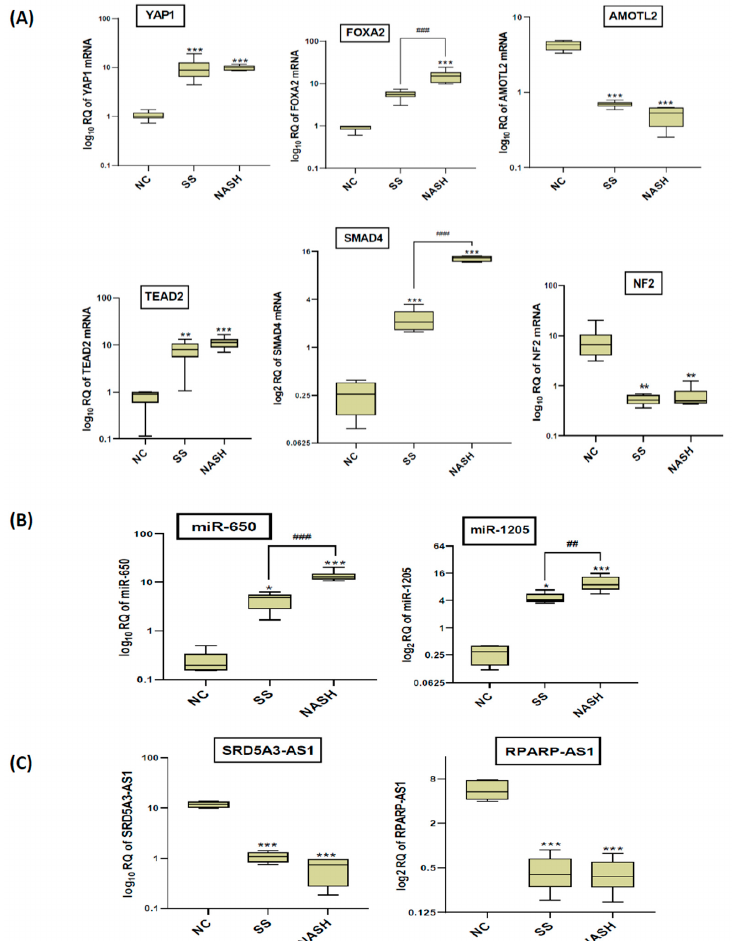
Figure 3. Histopathological changes in liver tissue of the experimental groups using HE and Masson’s Trichrome stains. ( A , D ) sections from NC group exposed to normal pellet diet; ( B , E ) sections from SS group exposed to HSHF for nine Figure 4. The expression levels of the constructed network members in the experimental groups. ( A ) YAP1, FOXA2, AMOTL2, TEAD2, SMAD4 and NF2 m-RNAs. ( B ) miR-650 and miR-1205. ( C ) lncRNAs SRD5A3-AS1 and RPARP-AS1. weeks; ( C , F ) sections from NASH group exposed to HSHF for 12 weeks (magnification: 200×). NC, Naïve control group; Data are presented as log fold change; number of animals = six rats/group. *** p < 0.001, ** p < 0.01 compared with NC SS, simple steatosis; NASH, non-alcoholic steatohepatitis; HSHF, high sucrose high fat diet; HE, hematoxylin and eosin group; ### p < 0. 001 and ## p < 0.01 significant differences between the two selected groups. RQ, relative quantification; NC, naïve control group; SS, simple steatosis; NASH, nonalcoholic steatohepatitis.